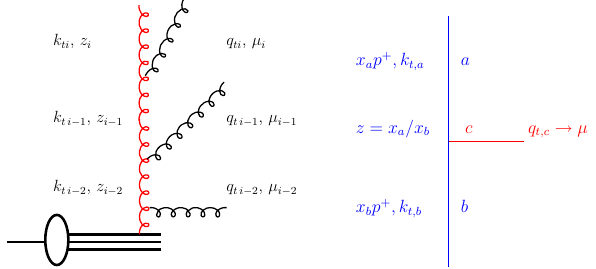
Fig. 4 Left: schematic view of a parton branching process. Right: branching process b → a +